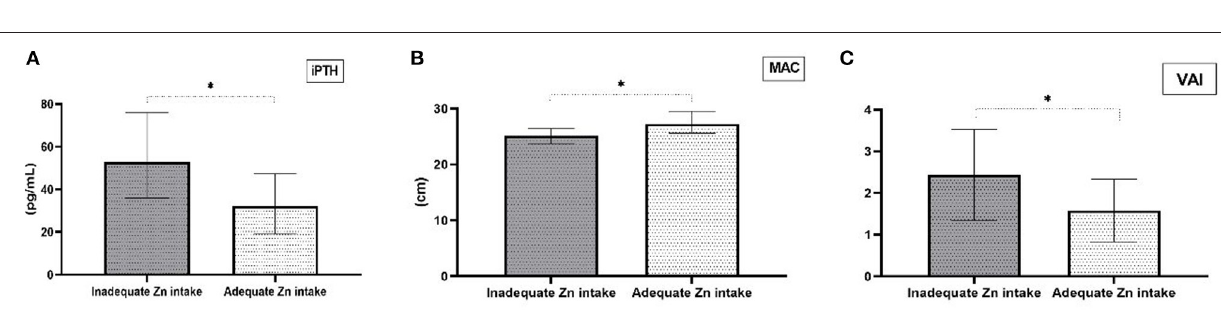
and VFA (r = 0.327, p = 0.040). Serum copper concentration directly correlated with BMI (r = 0.384, p = 0.014) and VFA ( r = 0.361, p = 0.023) and inversely correlated with serum albumin concentration ( r = − 0.449 p =